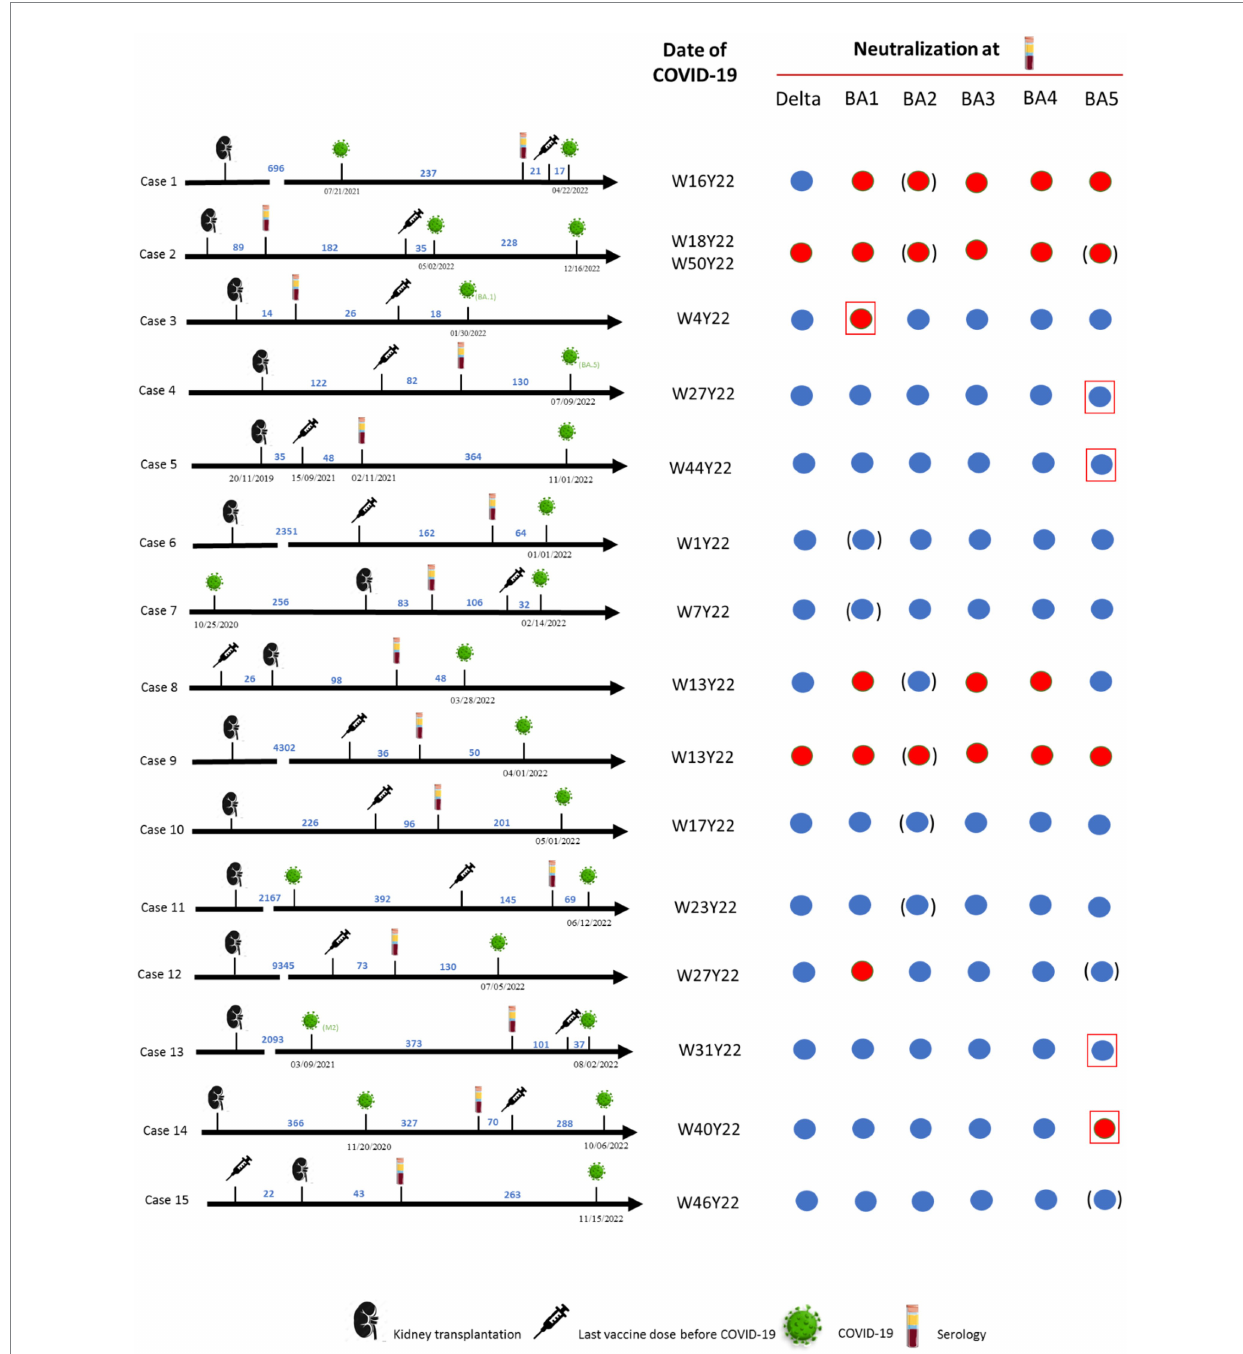
FIGURE 7 Breakthrough infections after seroneutralization study. Chronograms including events such as kidney transplantation, the last dose of vaccine before COVID-19, serology and COVID 19, are represented for 15 of the 38 patients, all of whom were kidney transplant recipients, at the last follow-up (December 28, 2022). The date of COVID-19 is given in form of Week (W) and Year (Y) numbers. The results of the seroneutralization of the Delta, Omicron BA.1, BA.2, BA.4 and BA.5 variants at the time of the serology are presented: the disk is blue if neutralization was observed, and red if not. If the virus responsible for COVID-19 was genotyped at our laboratory, the concerned variant in question is framed by a red square. In other cases, the supposed variant is circled by blue brackets, according to the weekly incidence of each major SARS-CoV-2 mutant and variant, based on the genotyping performed at our